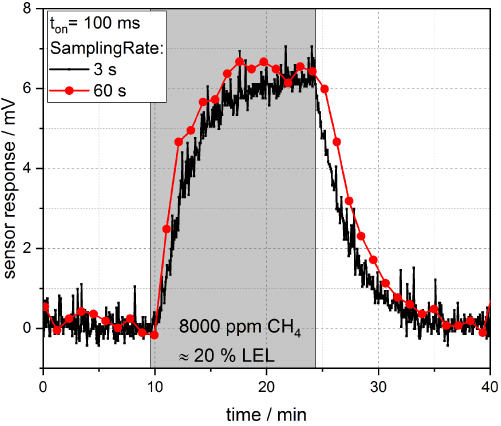
Figure 5. Sensor response to 8000ppm methane at a sensor temper- ature of 350 ◦ C and a sampling rate of 3 and 60s in dry synthetic air at an ambient temperature of 25 ◦ C. The implementation of dif- ferent application scenarios in relation to the required measurement interval and the desired battery lifetime is shown.